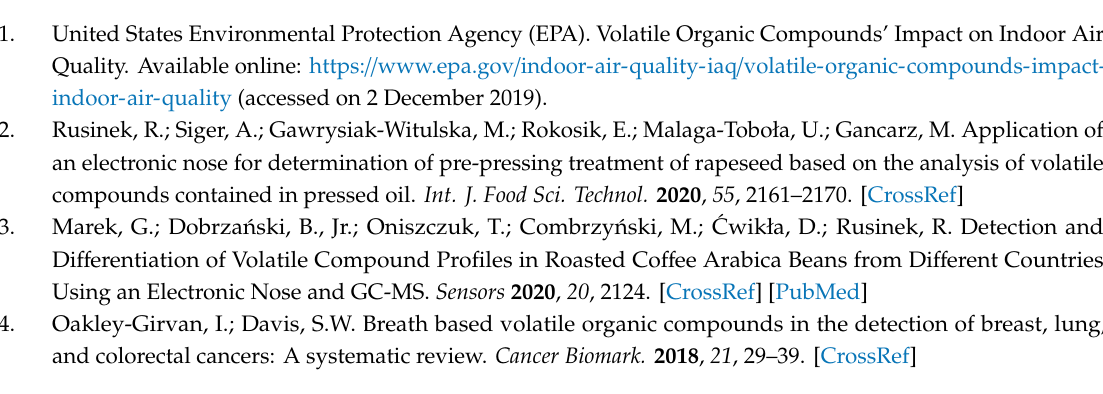
Calibration procedure. Figure S1: Calibration curves of the sensor TGS 2602 for di ff erent concentrations of ( a ) IPA, ( b ) Acetone, and ( c ) Ethanol. Figure S2: The output curves of ( a ) MQ 136, ( b ) TGS 2602, ( c ) TGS 2610, ( d ) TGS 2611 over a period of 7